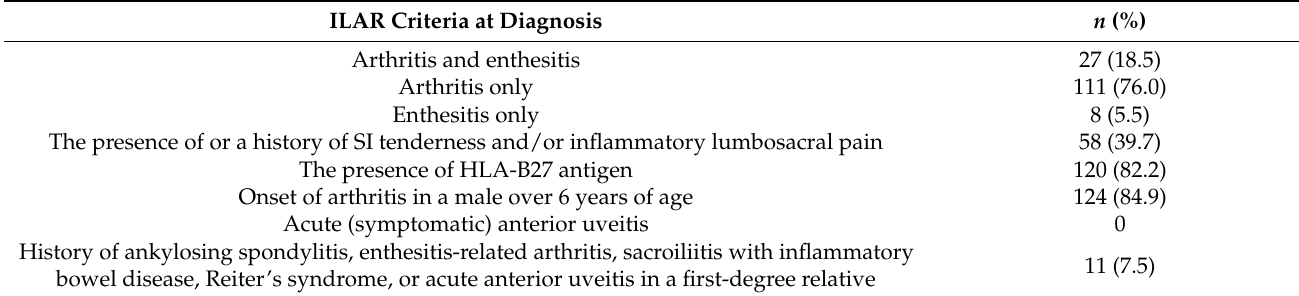
Table 2. ILAR criteria fulfilled at the time of diagnosis ( n =